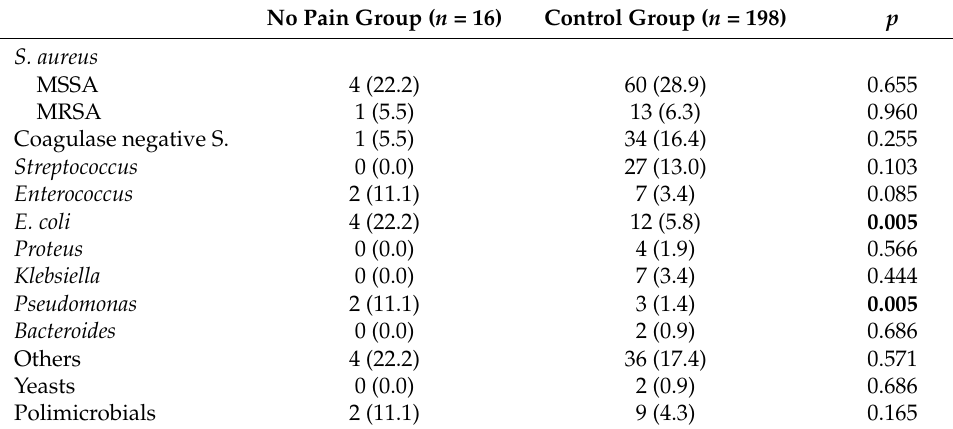
Table 3. Microbiology isolates for the two groups.